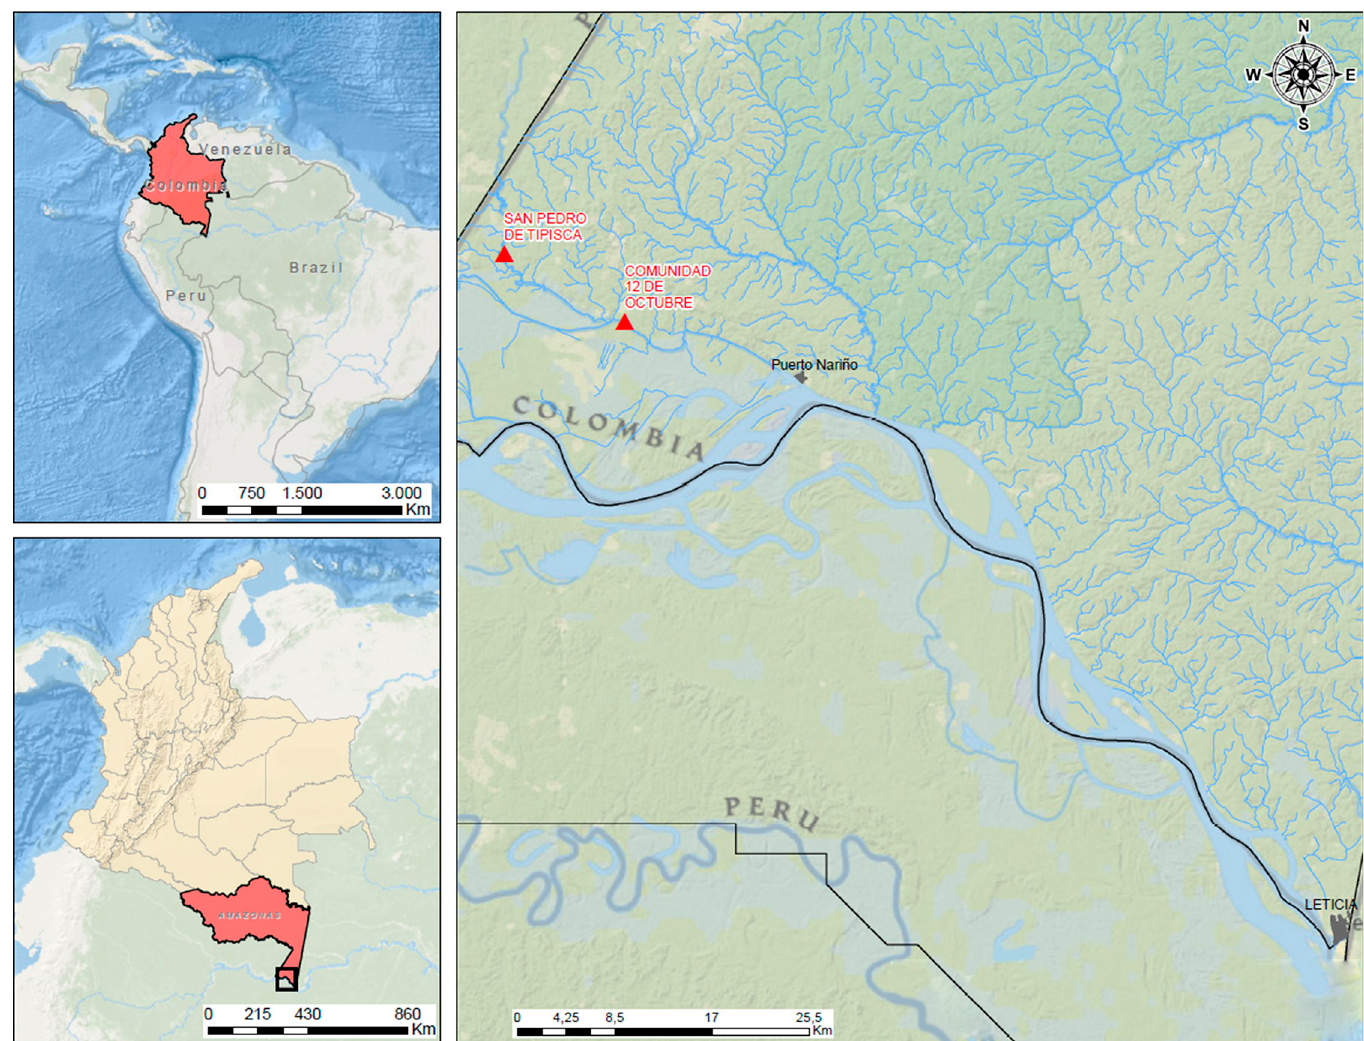
Fig 1. Map. Geographical location of both communities where mosquitoes were collected (the map has been modified from an Instituto Geogra´fico Agustı´n Codazzi (IGAC) template [20]. The images are open access, accessible and modifiable, according to IGAC